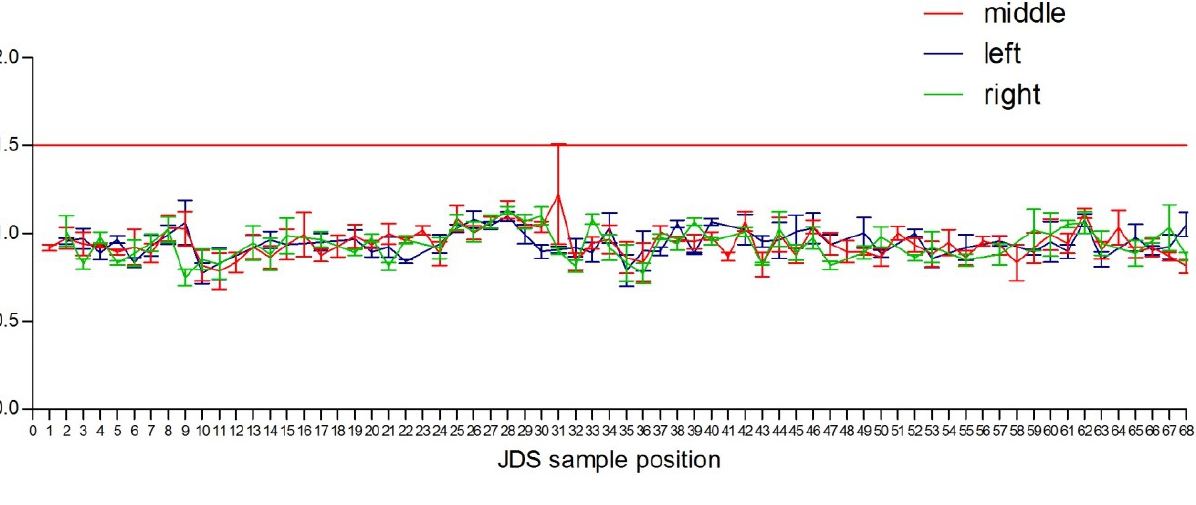
Figure 2. Results from umuC testing of the River Danube without enzymatic